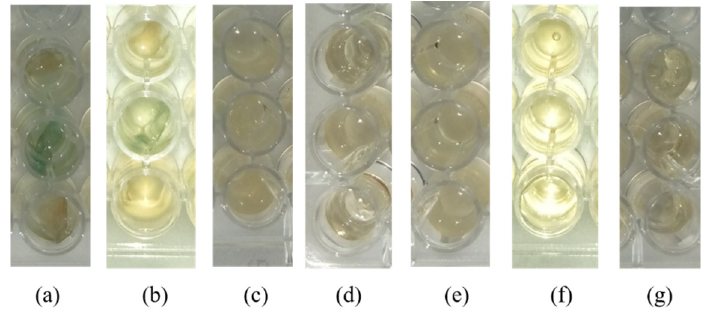
Figure 13. Photographs taken after 24 h for: ( a ) X-Gluc modified CS/PEO NFs in E. coli (OD 600 = 0.5, 2.36 × 10 7 CFU/mL) ( b ) X-Gluc modified CS/PEO NFs in E. coli cultures (2.36 × 10 6 CFU/mL), ( c ) unmodified CS/PEO NFs in E. coli cultures ( d ) pure LB, ( e ) E. coli cultures in LB, ( f ) unmodified CS/PEO NFs in LB medium and ( g ) modified CS/PEO NFs in LB (horizontal arranged wells are identical).